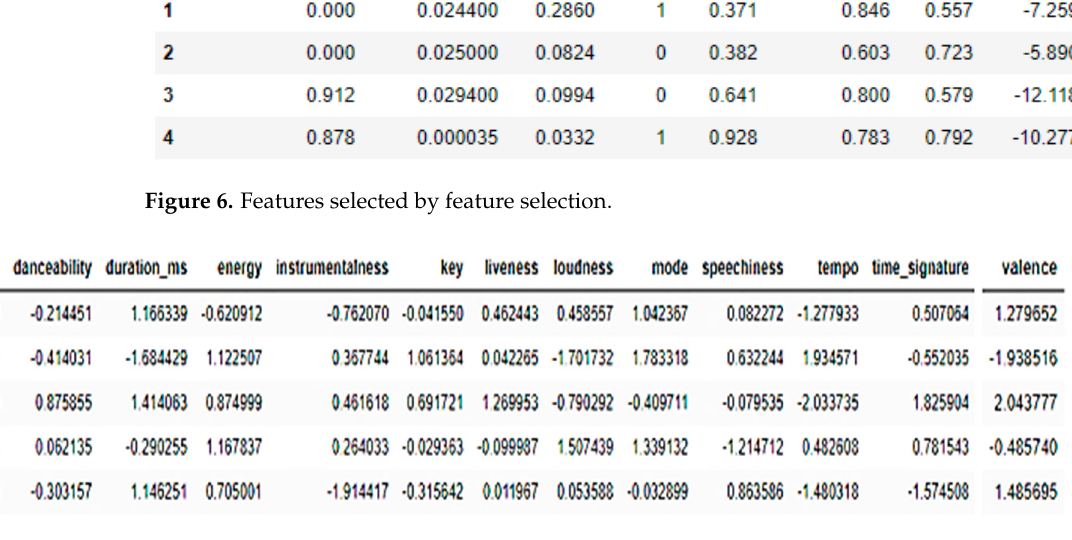
Figure 7. Features used without feature selection.